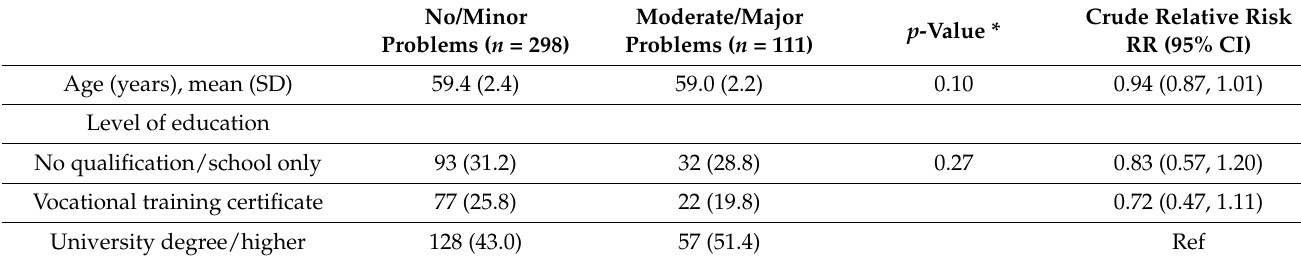
Table 1. Relationship between baseline socio-demographic and lifestyle factors and reporting diffi- culties coping with menopausal symptoms at work amongst 409 women who were working at the time of their menopause.